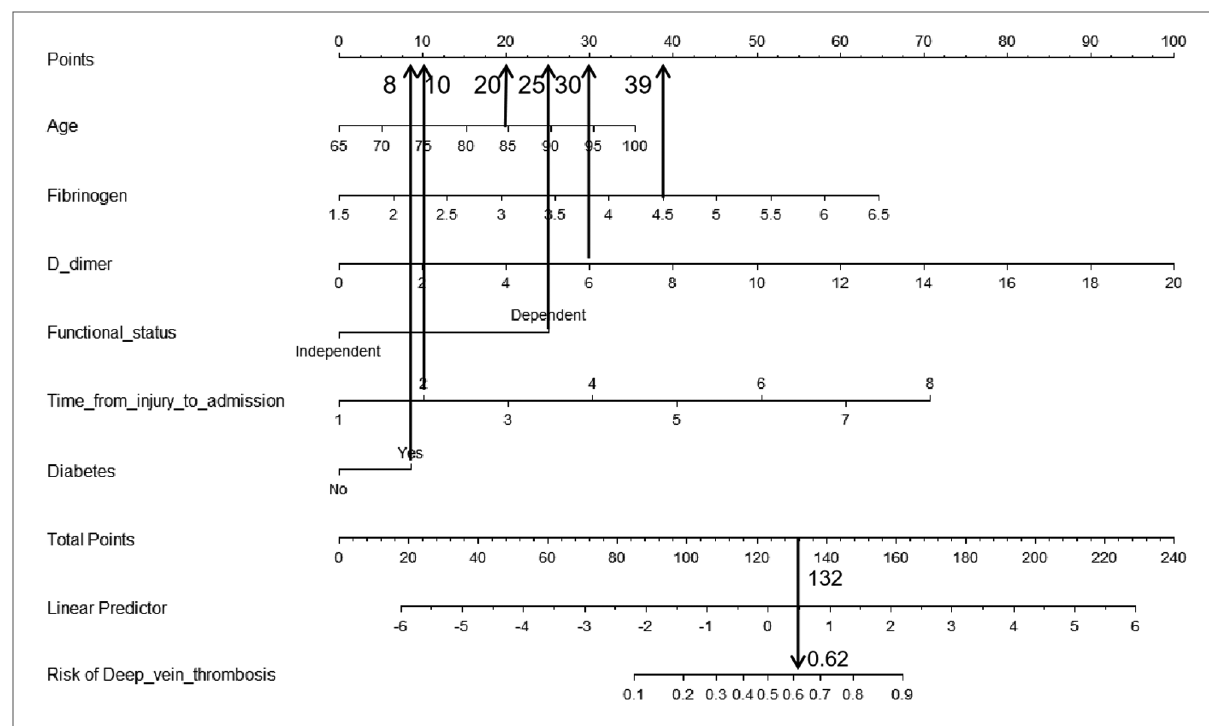
FIGURE 4 Calibration and decision plot of the nomogram for the probability of deep venous thrombosis. (A) Calibration plot. (B) Decision